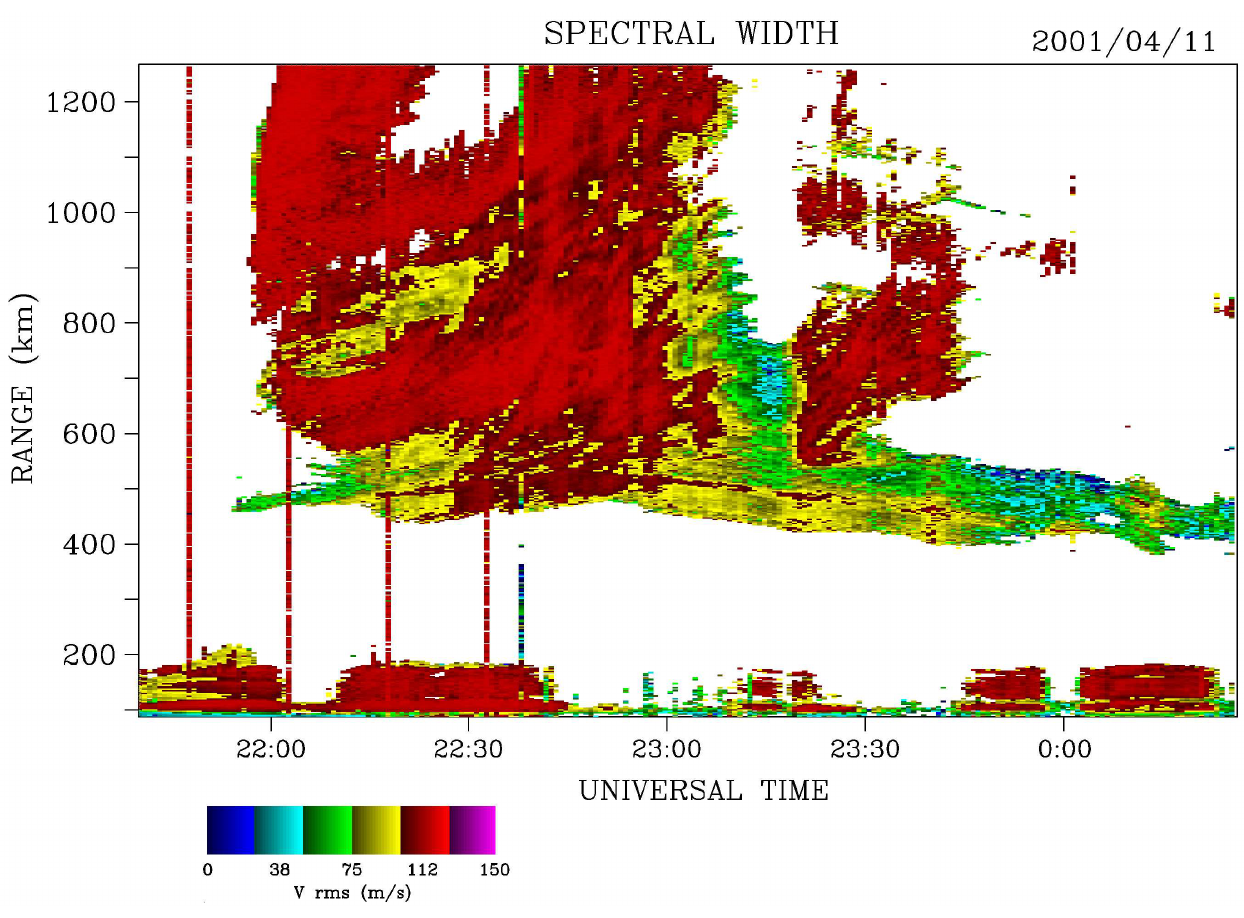
Fig. 5. The Range-Time-Spectral width plot on 11–12 April